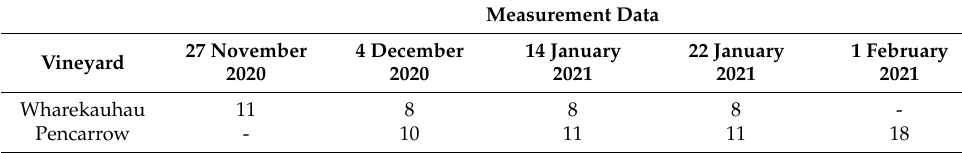
Figure 3. Surveyed canopies (blue points) in Wharekauhau ( a ) and Pencarrow ( b ) vineyards. Table 1. The number of surveyed canopies on each measurement